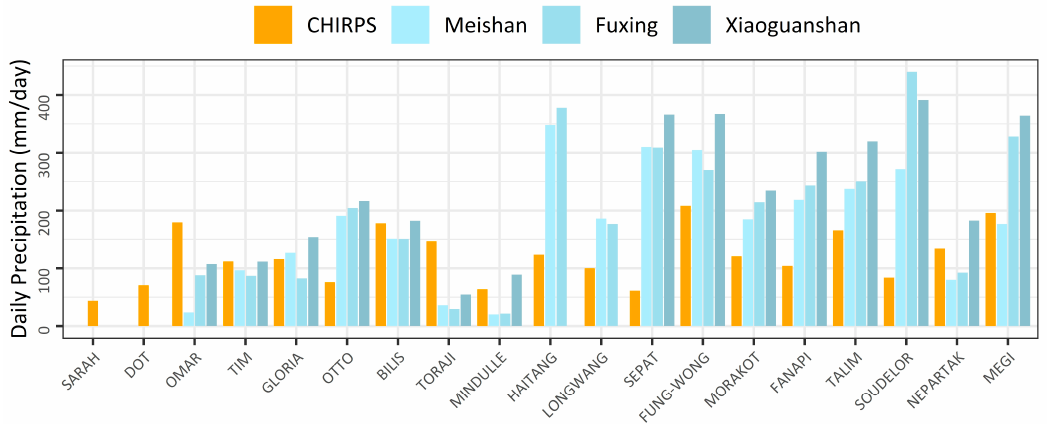
Figure 6. Comparison of daily precipitation for Climate Hazards Group Infrared Precipitation with Station (CHIRPS; orange) and CWB (blue palette) data for the selected 19 typhoon events.